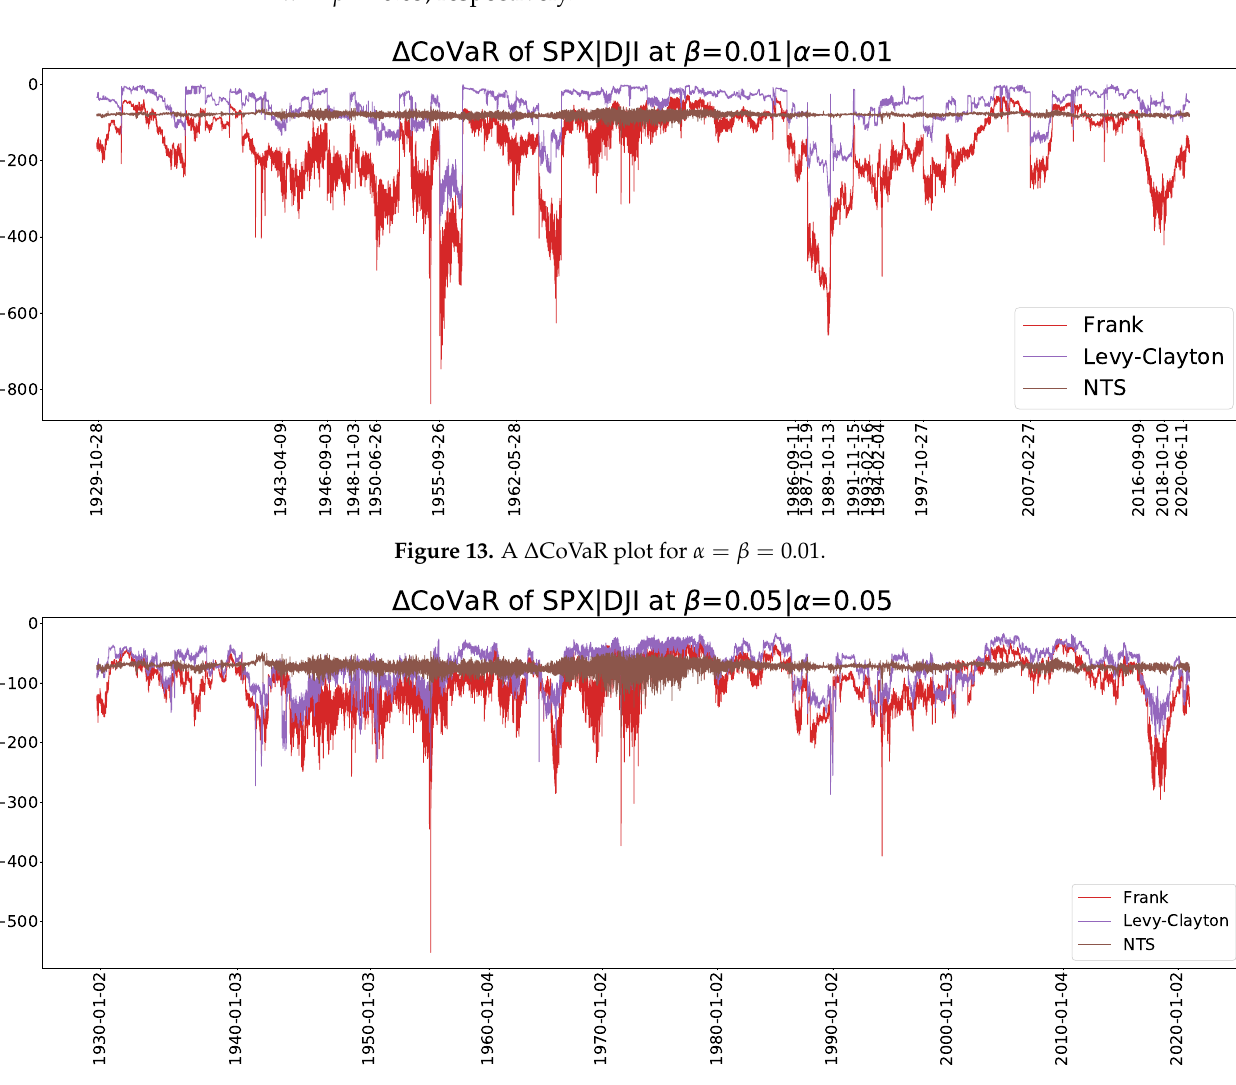
Figure 14. A ∆ CoVaR plot for α = β =